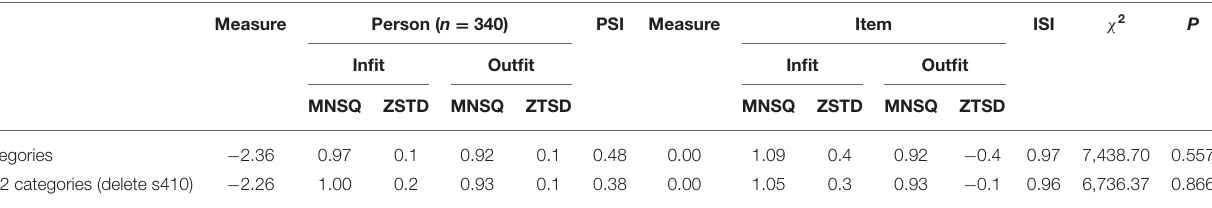
TABLE 5 | Summary of results of the Rasch